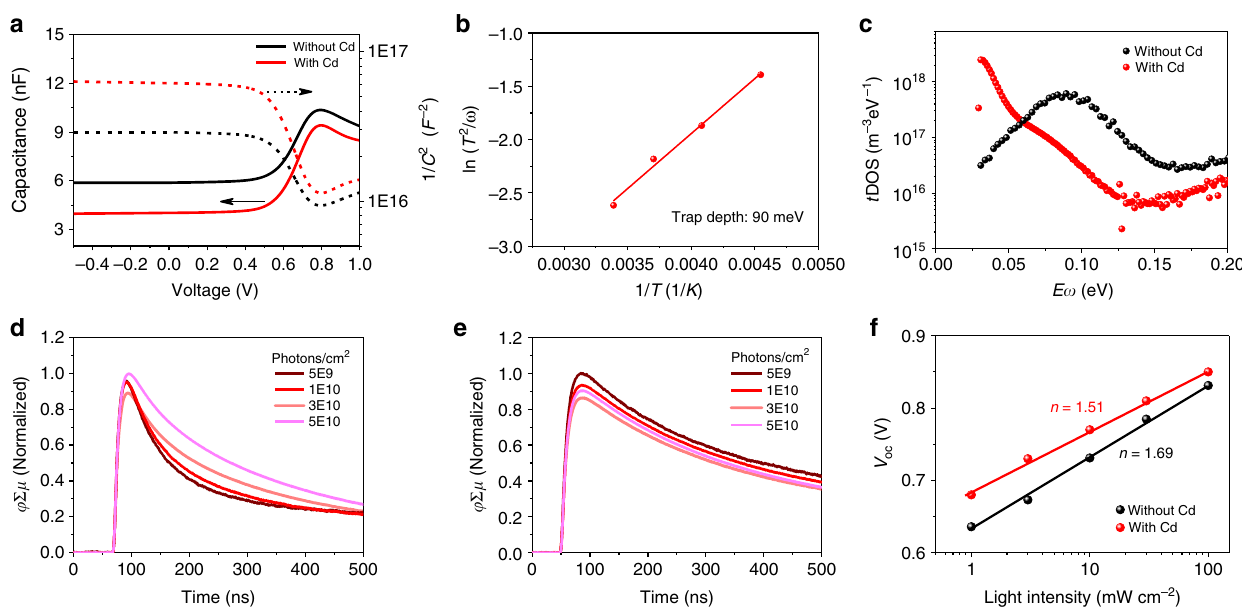
Fig. 4 In fl uence of Cd 2 + ions on the carrier concentration and t DOSs. a Capacitance – voltage curves of NBG PSCs with and without Cd 2 + ions at 295K. b ln ( T 2 / ω ) vs 1/ T curve for determining the trap depth and attempt-to-escape angular frequency. c t DOS studies of NBG PSCs with and without Cd 2 + ions at 295K. d and e TRMC measurement for electron carrier property with a structure of quartz/PEDOT:PSS/NBG perovskite fi lms without ( d ) and with ( e ) Cd 2 + ions. The intensities are normalized to the highest peak intensity. f V OC evolution with light intensity of NBG PSCs with and without Cd 2 + ions. All studies in Fig. 4 are based on 1000-nm-thick perovskite fi lm. Source data are provided as a Source Data fi le